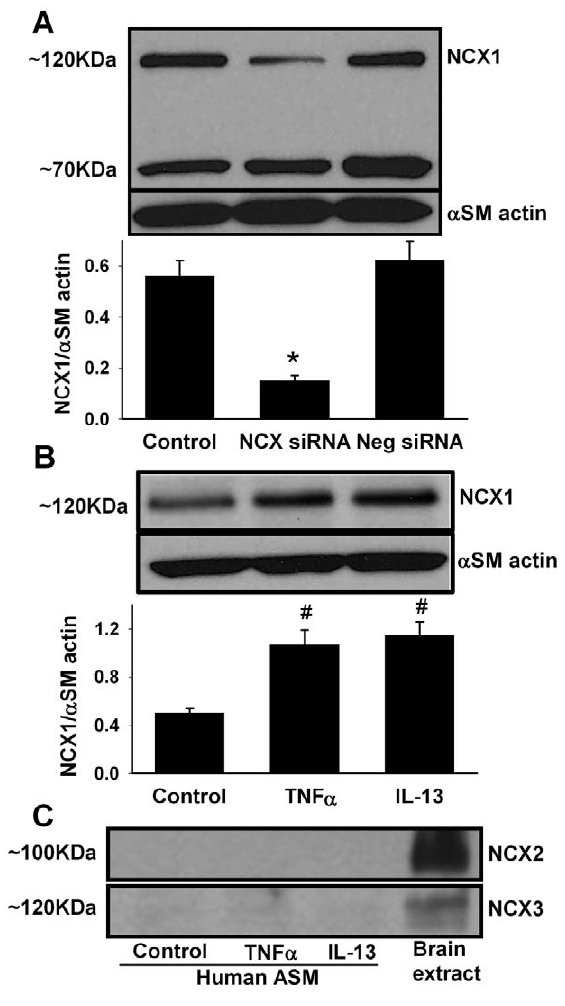
Figure 1. Effect of cytokines on expression of Na + /Ca 2 + exchanger (NCX) protein isoform NCX1 in human airway